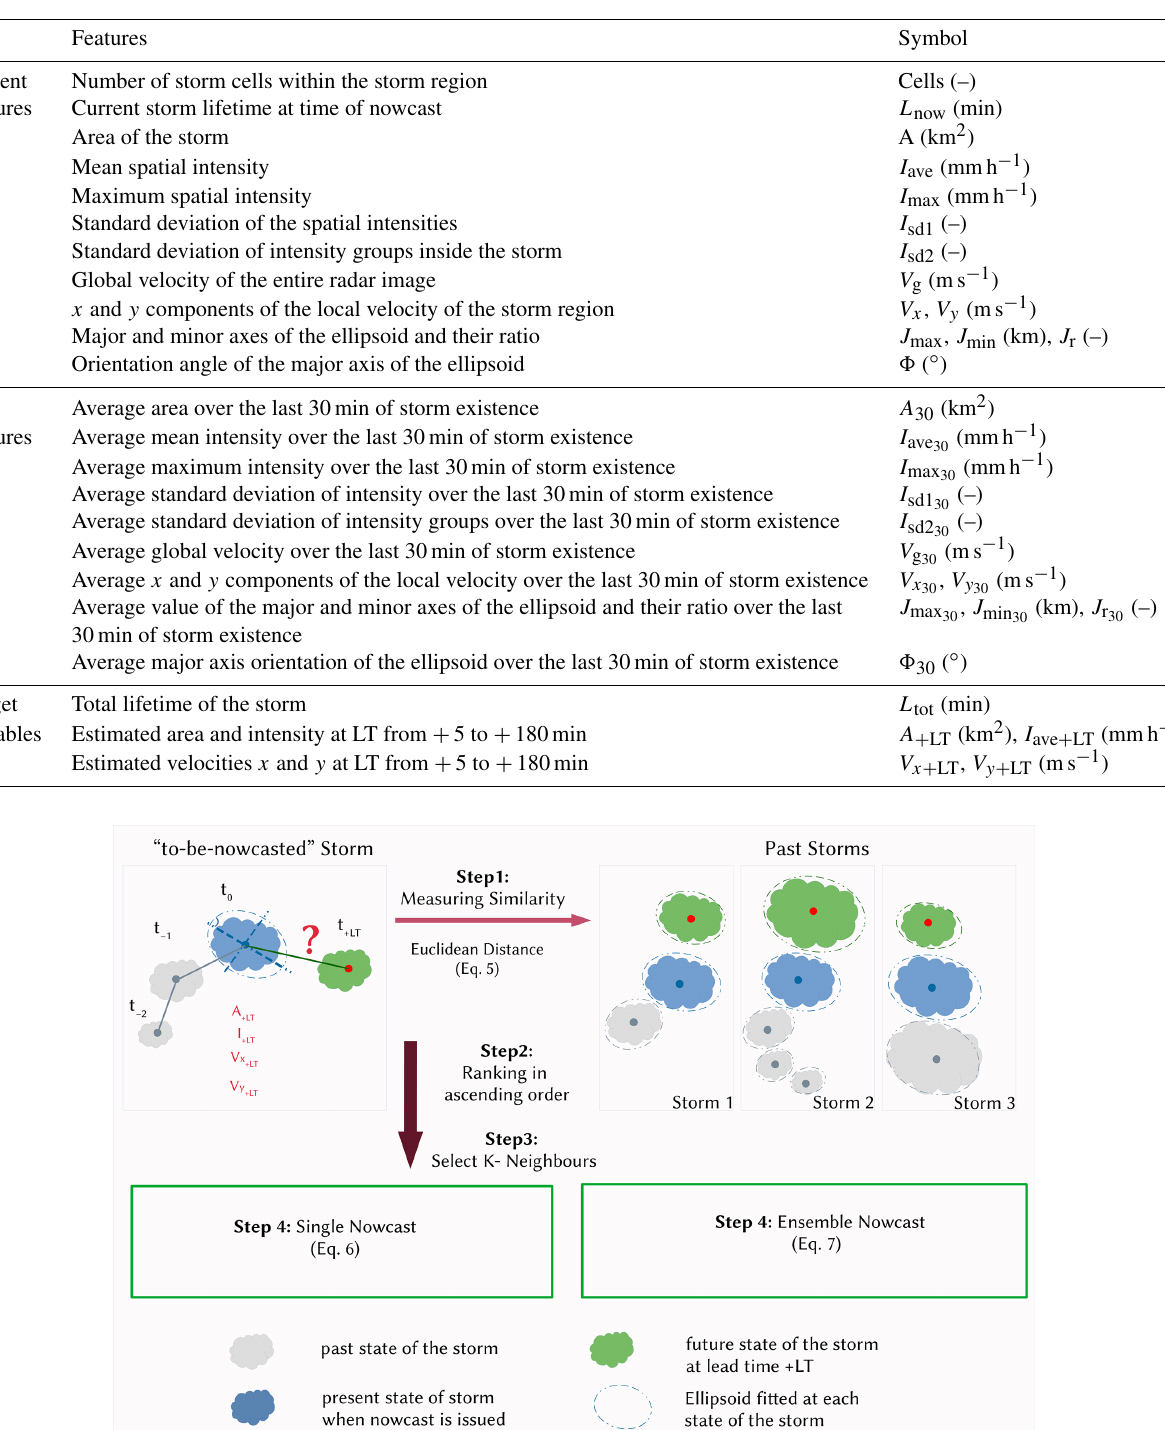
Table 1. List of all the past and present features of the storms that are investigated for their importance as predictors, and the respective target variables calculated for different lead times.